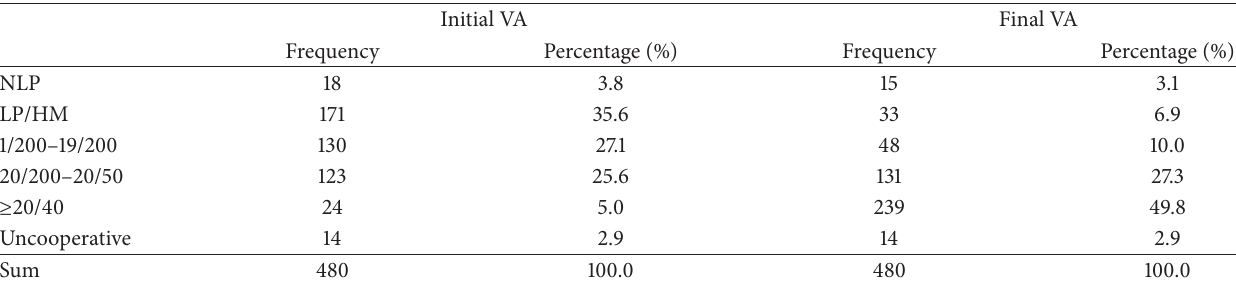
Table 2: The initial and final VA.